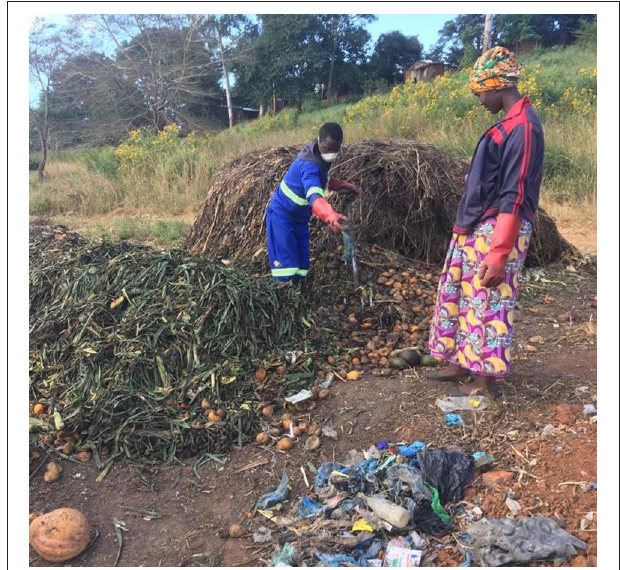
FIGURE 1 | Raw organic waste arrives on site and is sorted before being transferred to the composting